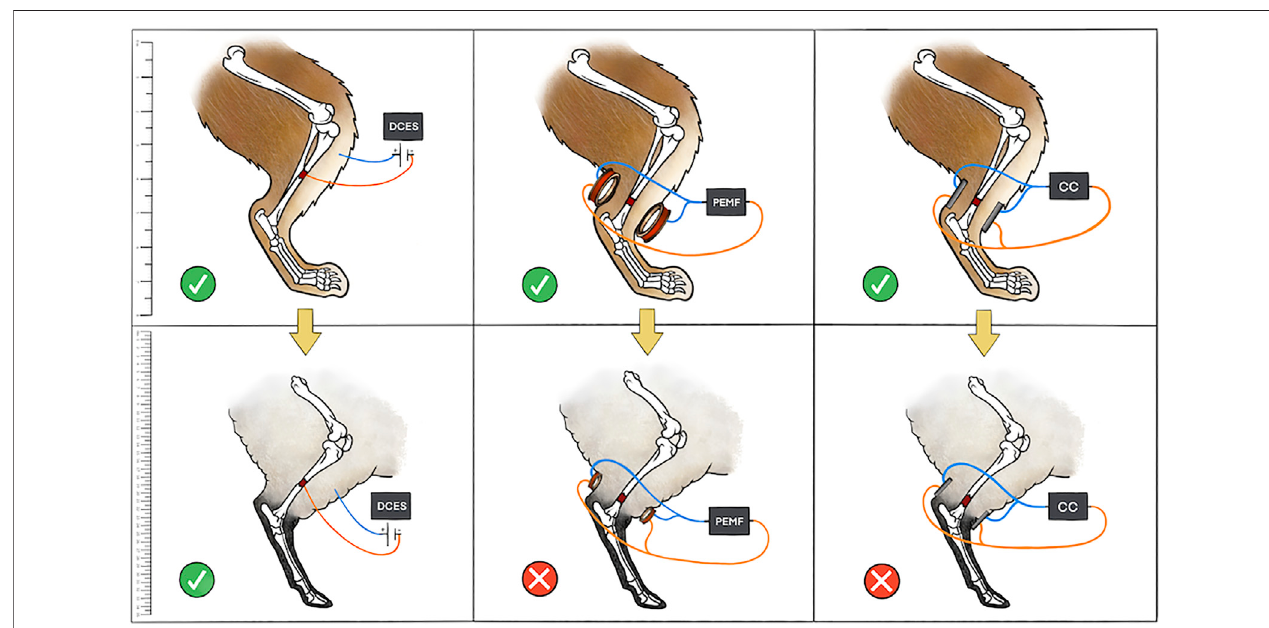
FIGURE 4 | Depicted is a pictorial schematic of the three types of ES discussed in the manuscript in both a small and large animal model. The small animal model (rabbit) is in the top panels with a yellow arrow symbolizing translation to a large animal model (sheep) in the bottom panels. A green check means that the ES was successfulinstimulatingbonegrowth, whereasared “ X ” meansthattheEStreatmentwasnotsuccessful.TheauthorsattributeissuesofscalewithCCandvariationsin limb soft tissue and bone thickness with PEMF to the lack of success of non-invasive ES modalities in large animals. Scale bar on left for reference.